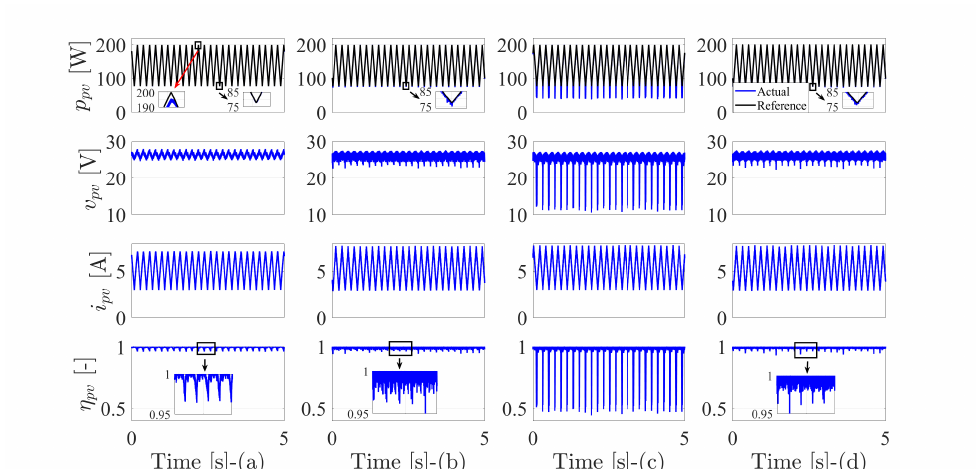
Figure 8. The performance of the MPPT techniques under dynamic weather conditions: ( a ) Fixed switching MPPT-based digital observer. ( b ) MPPT-based FS-MPC. ( c ) The first proposed DMPPT technique-based direct P&O. ( d ) The second proposed DMPPT technique-based indirect P&O.